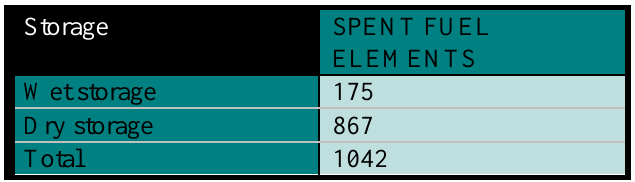
Figure 3. Inventories of used fuel at the Necsa Pelindaba